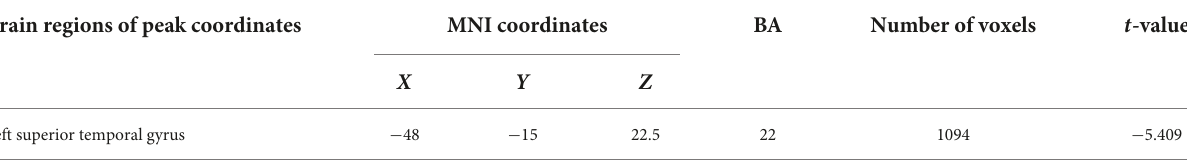
TABLE 3 Brain regions with significantly different VBM values of the PTSD at 2 days and 2 months. Brain regions of peak coordinates